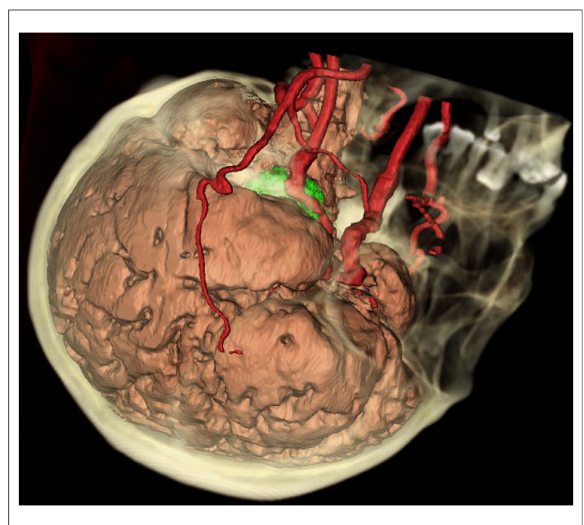
FIGURE 1 Integrated 3D model of the brain, vessels, and bones. The skull (yellow), the cerebral arteries (red), and the brain (pink yellow) were rebuilt separately. A tumor (green) could be seen in the petroclival region, surrounded by the skull base bones, the vessels, the cerebral lobes, and the brain